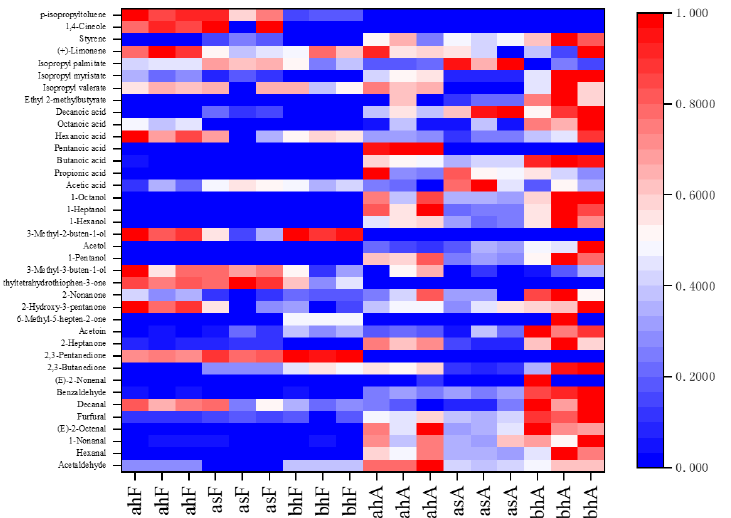
Figure 3. The heat map analysis of the six samples. Every square represents a volatile compound. If a compound had a lower concentration, the color of the square is close to blue, otherwise, the color is close to